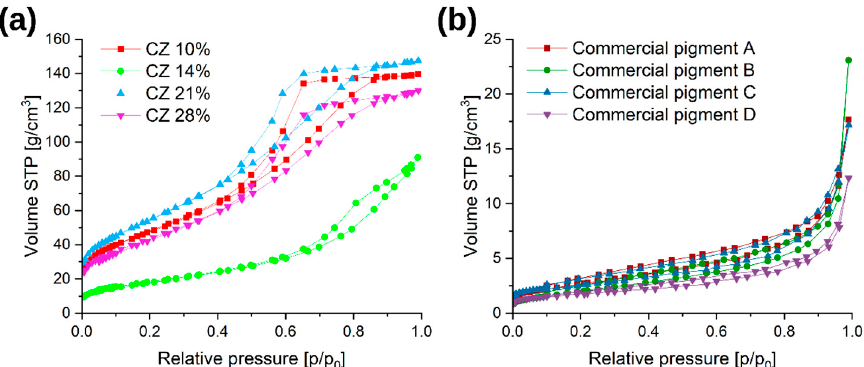
Figure 8. Results obtained from BET analysis: ( a ) nitrogen adsorption isotherms of laboratory pigments; ( b ) nitrogen adsorption isotherm of commercial pigments.